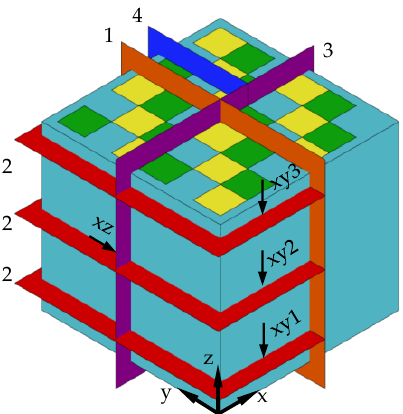
Figure 4. Arrangement of the cuts for the characterization with the indication of the view direction on curtain surfaces.